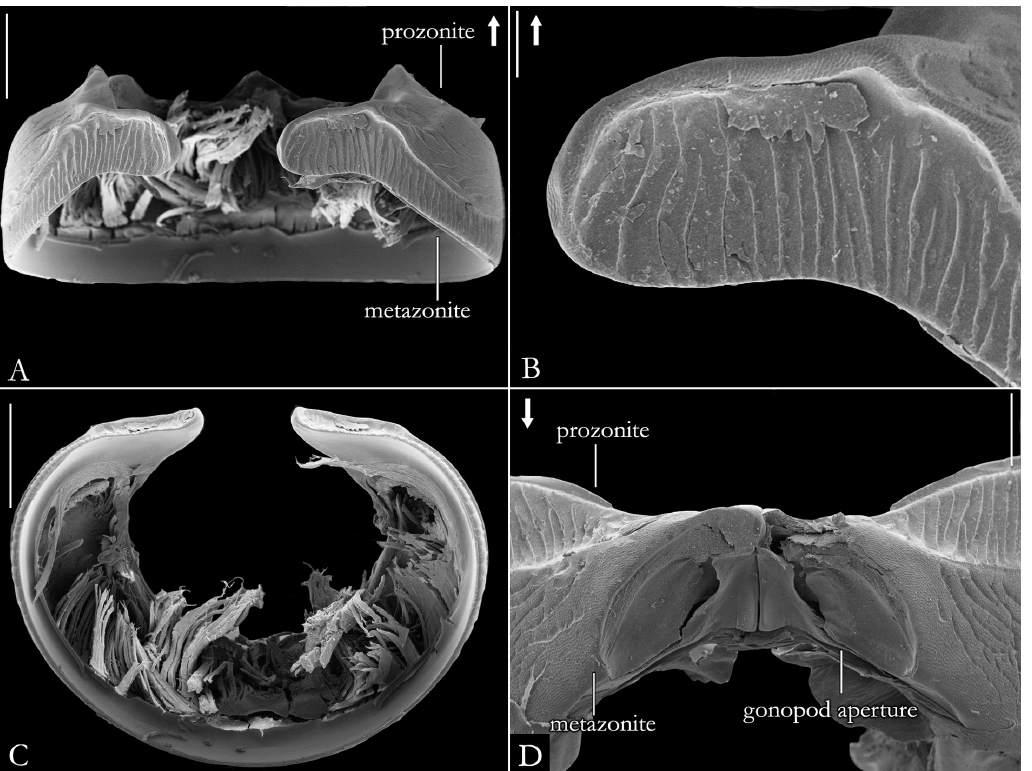
Fig. 37. SEM images of anterior body rings of males of Pseudonannolene erikae Iniesta & Ferreira, 2014 (IBSP 7607). A–B . Ventral view. C . Transversal view. D . Detail of seventh body ring with gonopod aperture. Scale bars: A, C–D = 1 mm; B = 0.2 mm.